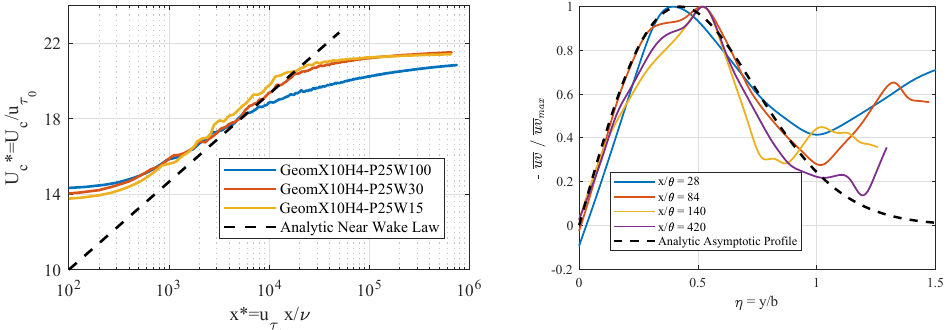
Figure 7. Comparison of the wake characteristics with empirical models in the near wake region ( left ) and the intermediate wake region (( right ), for the computation GeomX10H4-P25W30, at different streamwise positions x / θ ).